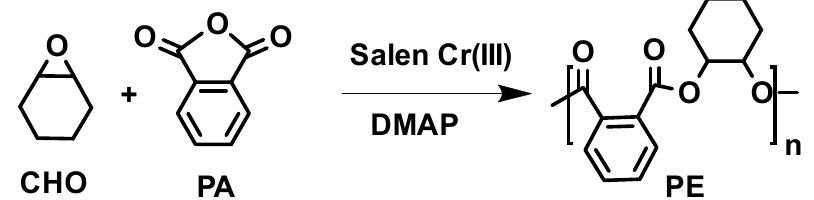
Scheme 1. Ring-opening copolymerization (ROCOP) reaction between cyclohexene oxide (CHO) and